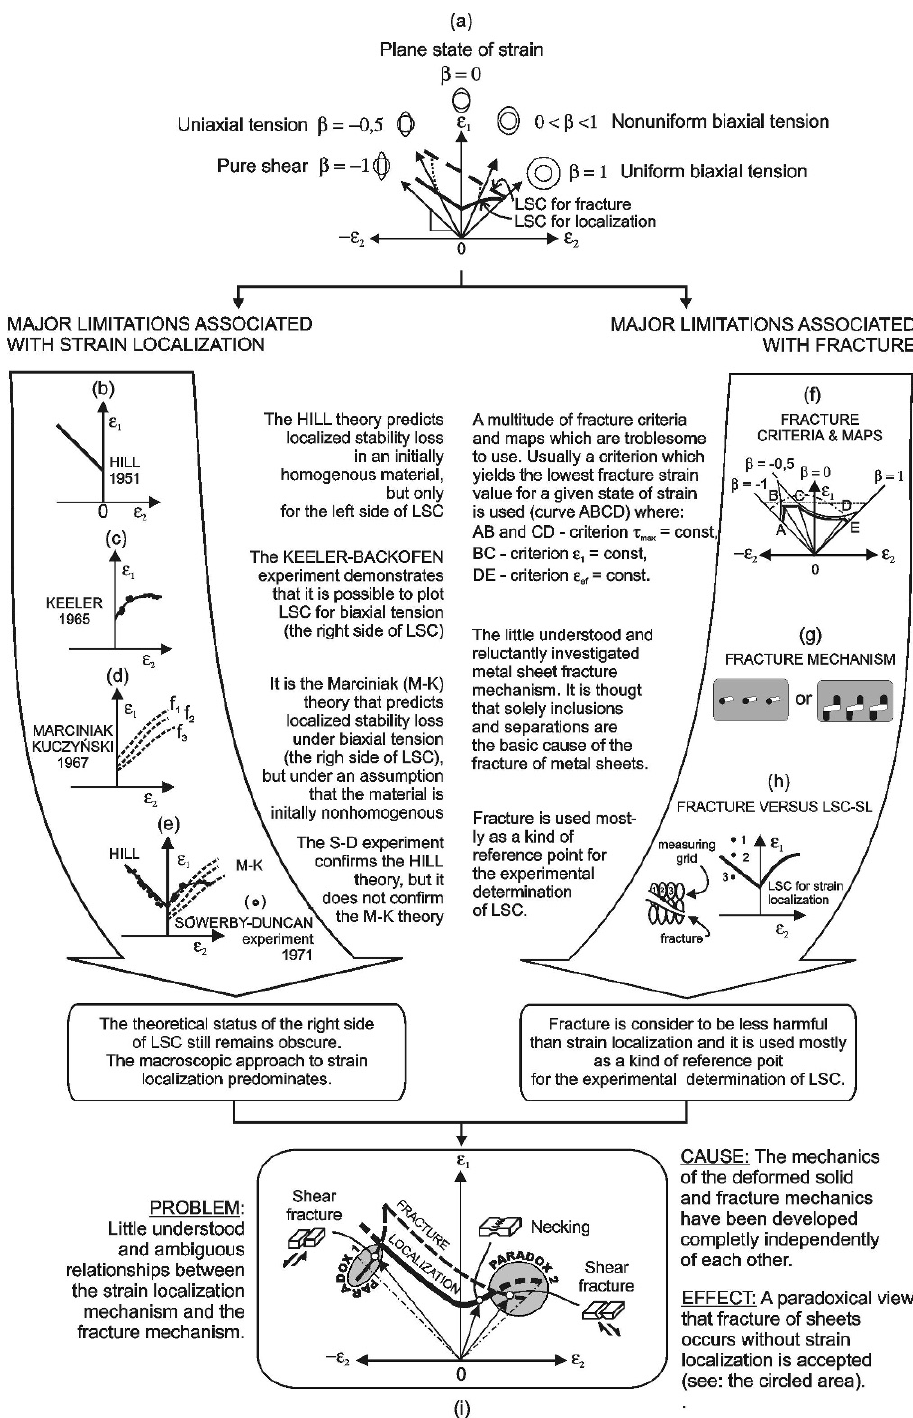
Figure 7. Synthetic illustration of problems related to limit strain curves (LSCs)